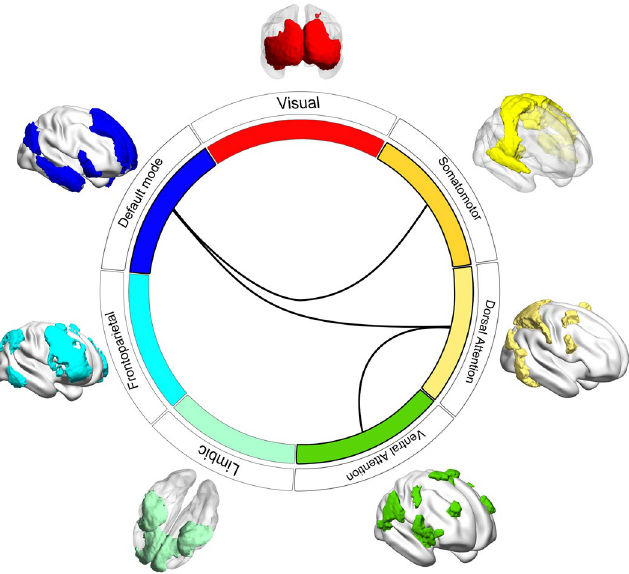
Figure 3. Set of connections from network-based statistics (NBS) showing higher functional network connectivity in response to natural as compared to built environmental stimuli. The different color bars represent the nodes, one per network of the Yeo template. The glass brain depicts the regions comprising each network. The lines represent the set of edges for which NBS identified differences in connectivity between conditions.